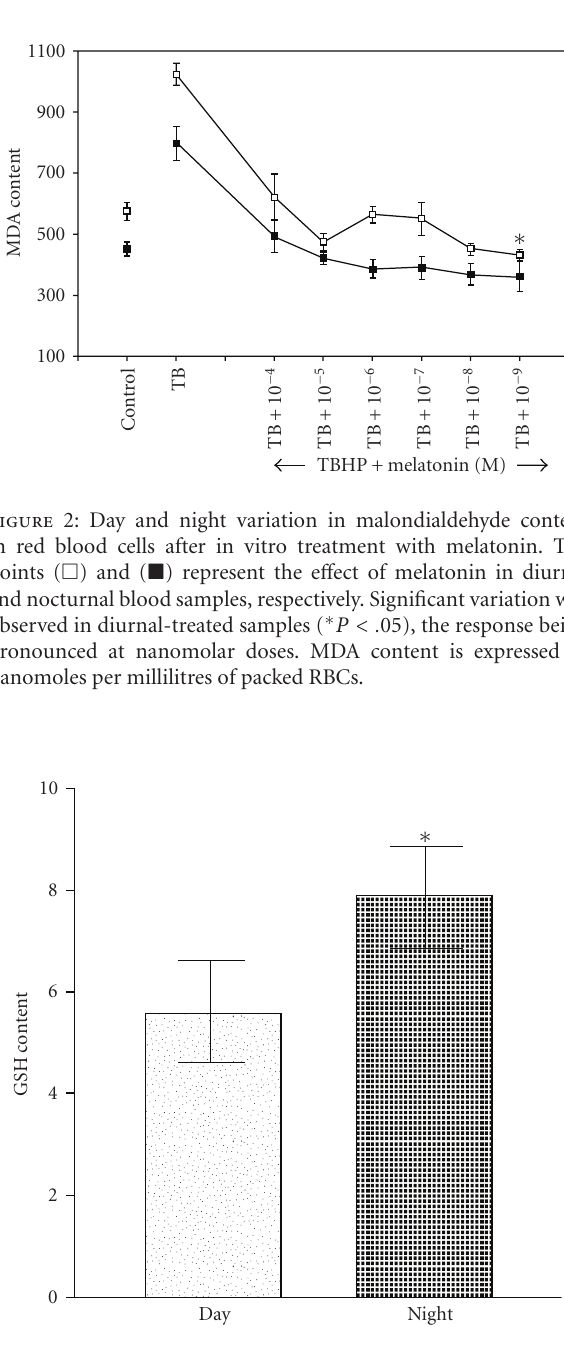
Figure 3: Day and night variation in intracellular reduced glu- tathione (GSH) content in red blood cells. Significant increase was observed in level of GSH in the diurnal samples ( ∗ P < . 05). GSH content is expressed as milligram per millilitre packed RBCs.